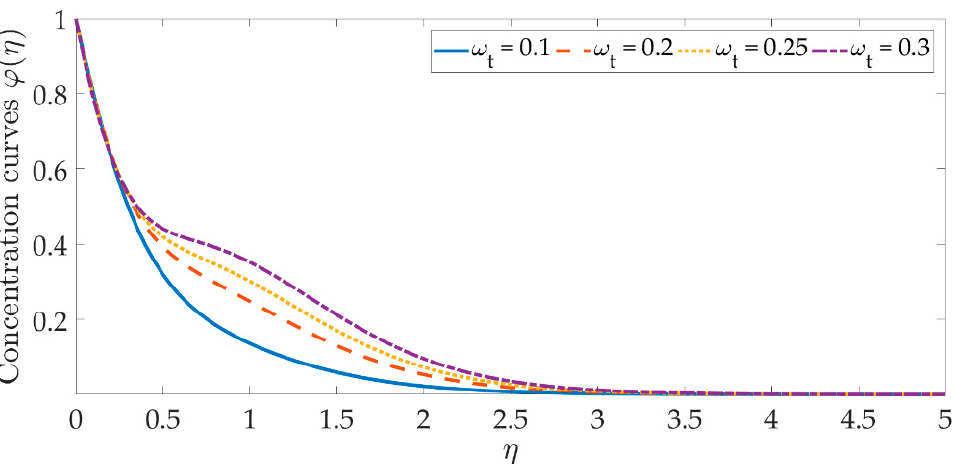
Figure 18. Concentration curves against the multiple values of . b